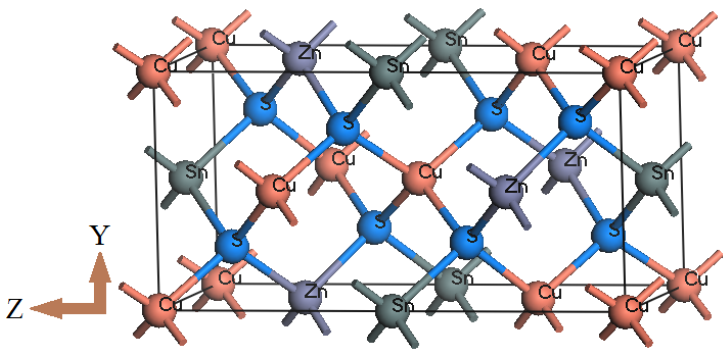
Figure 1. Cu 2 ZnSnS 4 unit cell structure.